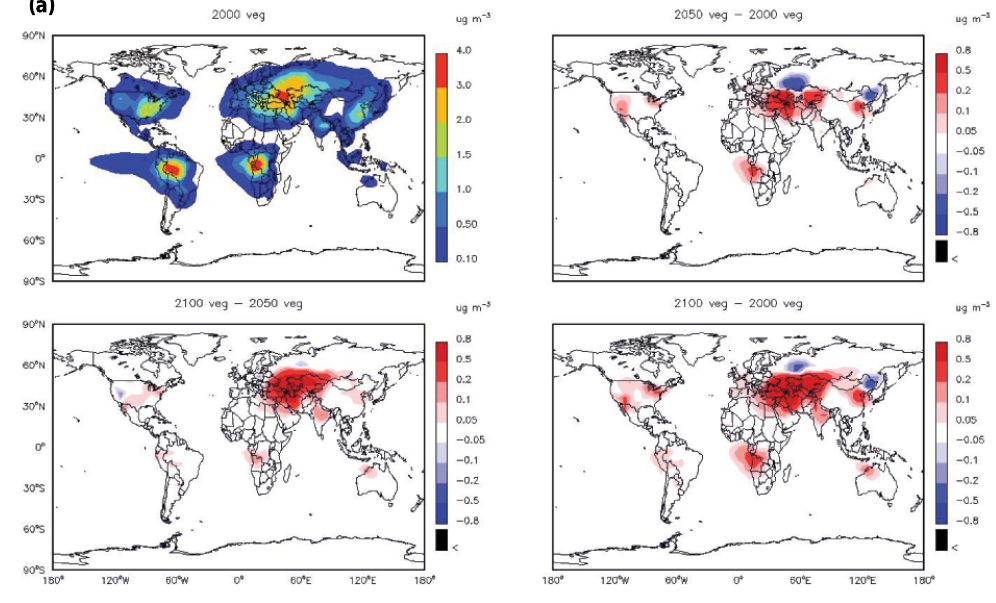
Fig. 4a. Same as Fig. 3 but for secondary organic aerosols. Color scales saturate.